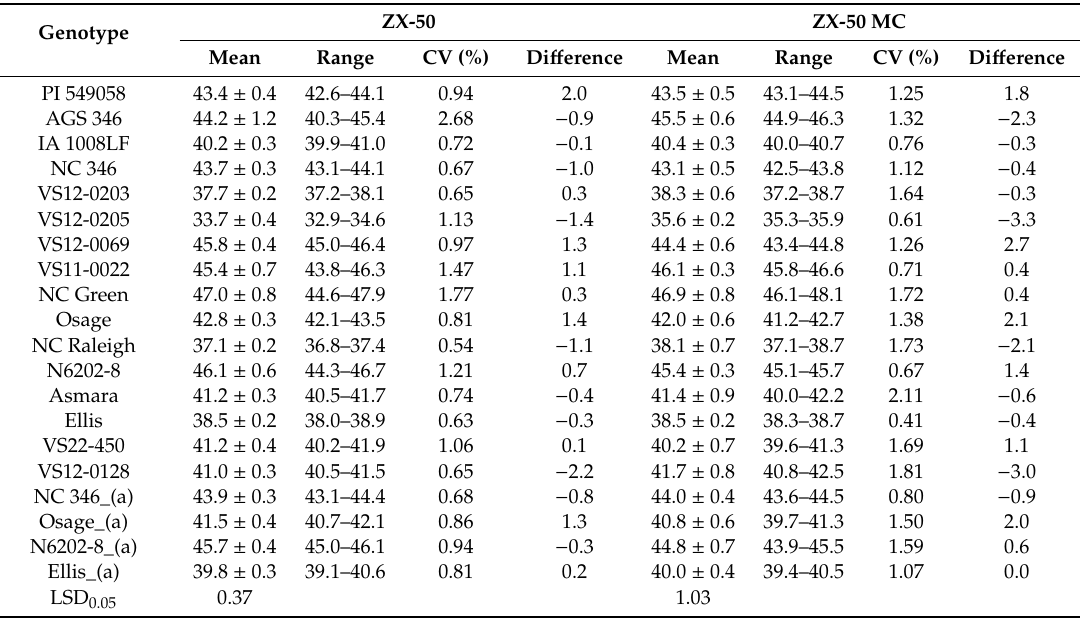
Table 4. Mean, range and coe ffi cient of variation of corrected protein content (g 100 g − 1 ) determined using ZX-50 NIR analyzer in 20 soybean genotypes / entries and the di ff erence from the values with DA 7250.